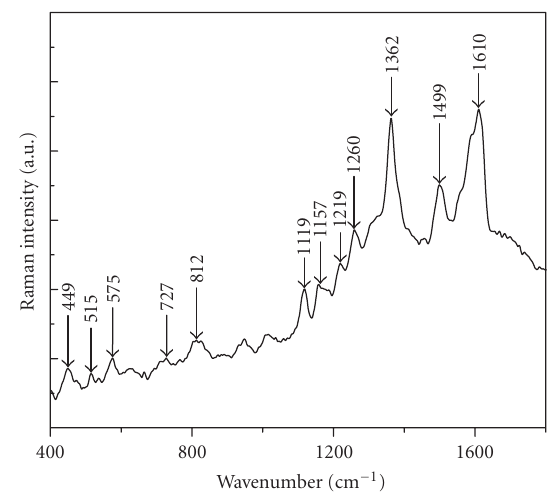
Figure 5: FT-Raman spectrum of an electrodeposited POT film (1064 nm excitation).